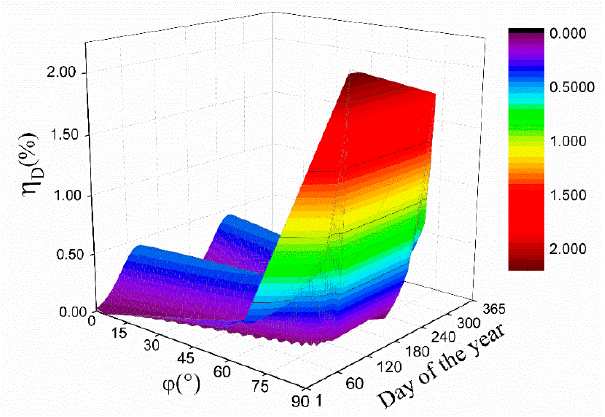
Figure 22. Surface chart of 𝜂 (cid:3005) varying with day of the year and different latitudes at 𝛽 = 0 .